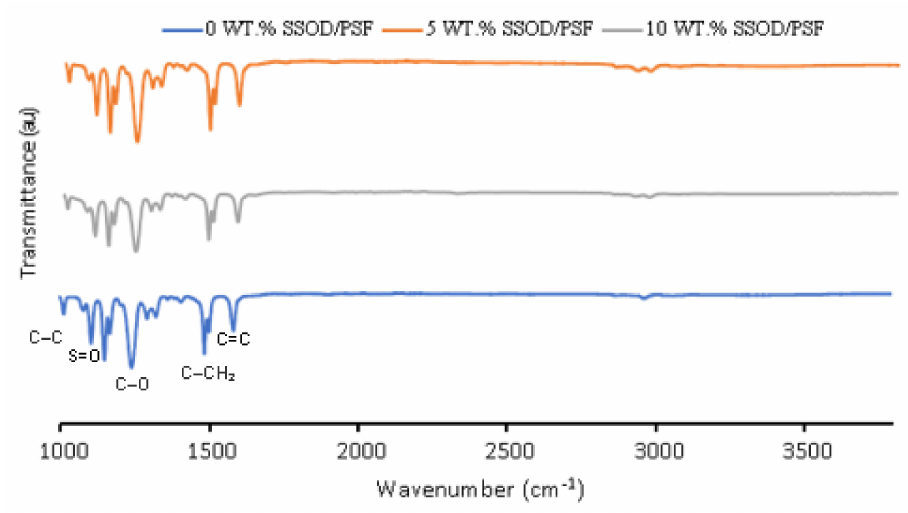
Figure 5. FTIR spectra for the fabricated membranes.